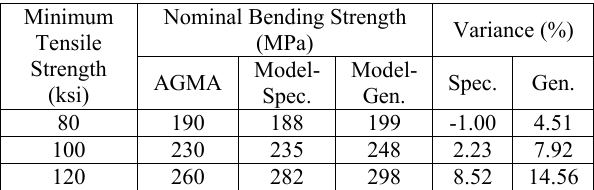
Table 3: Nominal Bending Strength Estimate Comparison for Ductile Cast Iron Materials Minimum Tensile